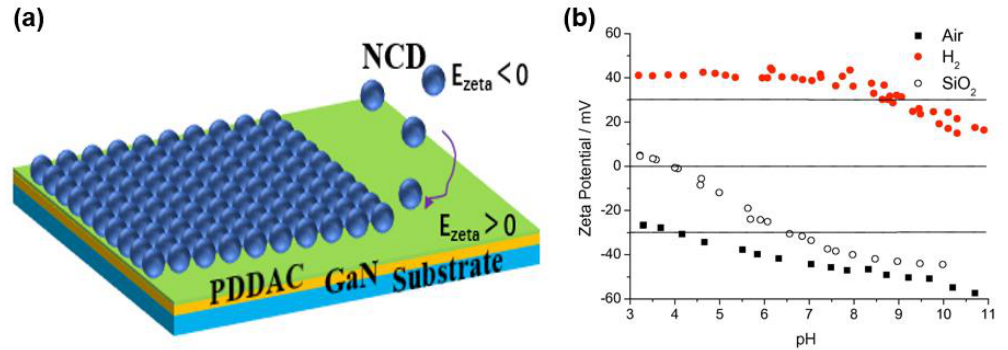
Figure 5. ( a ) The electrostatic grafting of negatively charged diamond nanoparticles on a cationic polymer-coated substrate. ( b ) Zeta-potential of a hydrogenated (H 2 ) and oxygenated (air) diamond colloid measured over a wide range of pH values